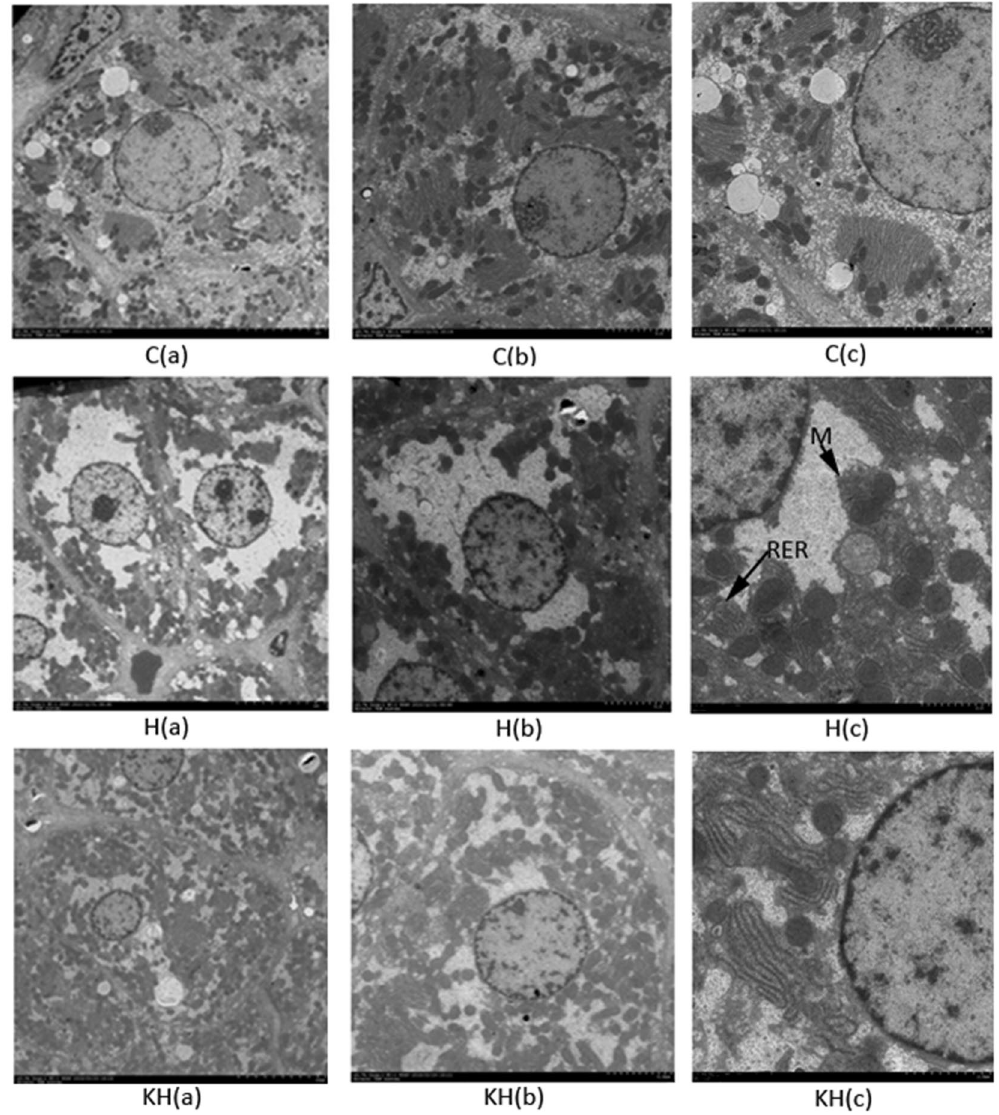
Figure 2. Transmission electron microscopy shows the dissolution of mitochondrial (M) membrane fragmentation (arrows) and the dilation of rough endoplasmic reticulum (RER) (arrows) within liver tissue. (a): Bar = 10 μ m; (b): Bar = 5 μ m; (c): Bar = 2 μ m. C: control group; H: Heat stress group; KH: Kisspeptin + Heat stress